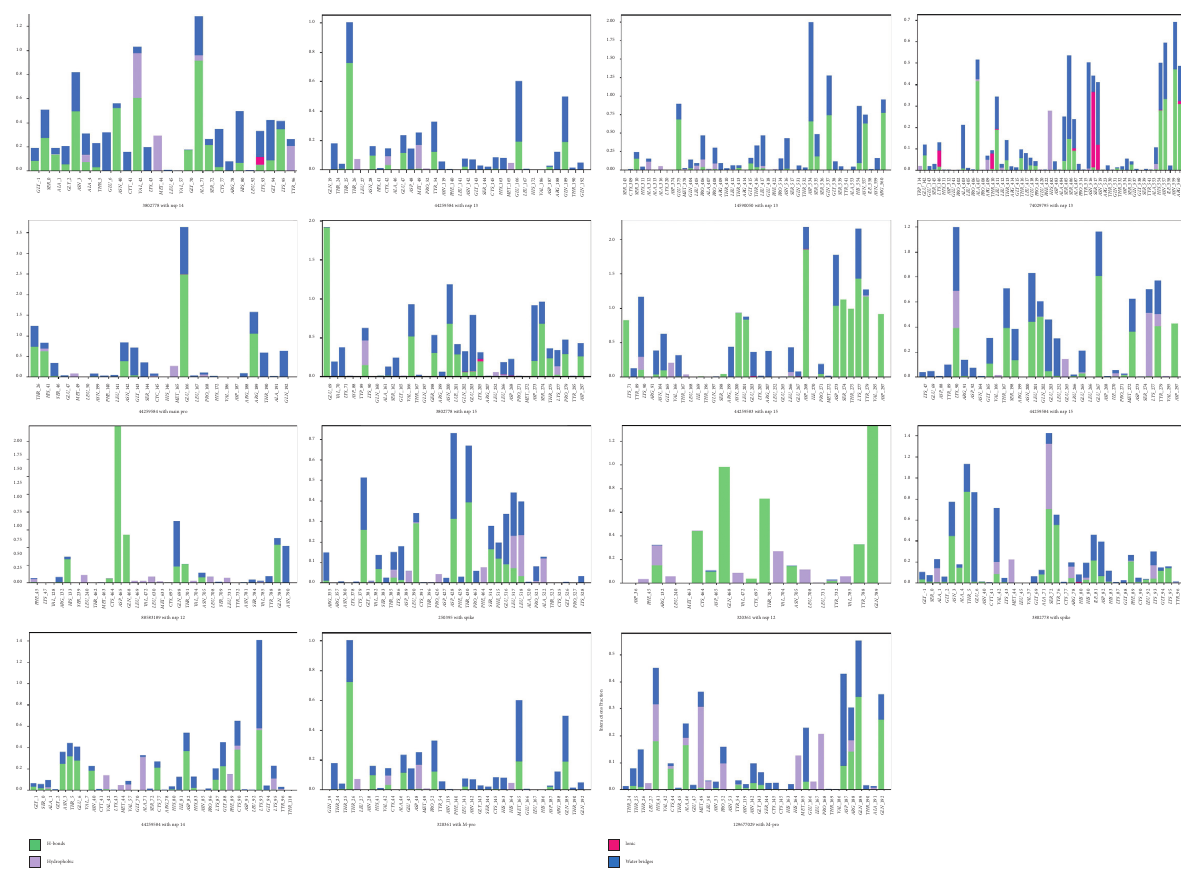
Figure 9: Histogram of hydrogen bond contact of top hit Kabasura Kudineer and homeopathy compounds with SARS-CoV-2 proteins. Hydrogen bonds are represented by green color, hydrophobic by purple, ionic bonds by pink, and water bridges by